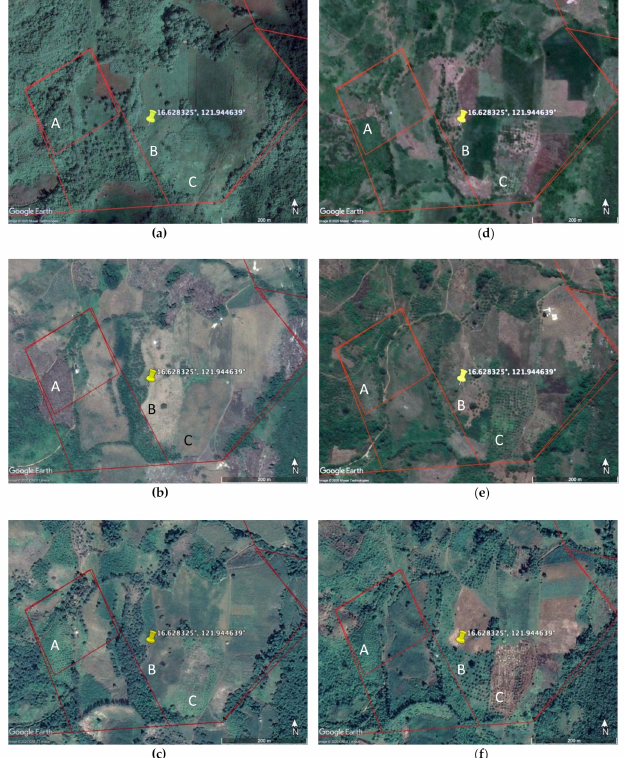
Figure 11. Actual changes in vegetation cover observed on ( a ) 30 January 2010; ( b ) 13 May 2014; ( c ) 23 February 2015; ( d ) 23 March 2017; ( e ) 18 June 2018; and ( f ) 17 February 2019, for a segment of the area within Site 2 (Pin location: 16.628325 ◦ , 121.944639 ◦ ) as observed using VHR RGB data accessed through Google Earth